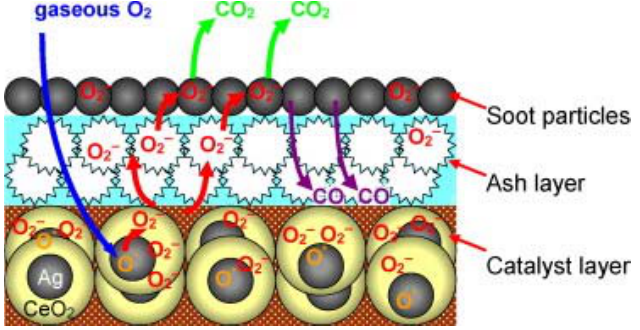
Figure 12. A schematic mechanism for remote catalytic soot oxidation over a catalyst composed of Ag and CeO 2 . Reproduced from Ref. [104] with the permission from the Elsevier.